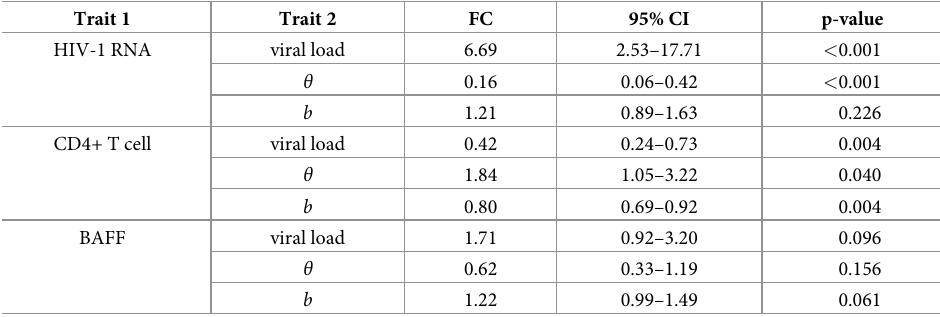
Table 1. Effects of plasma HIV-1 load, CD4+ T cell count and BAFF amount on the Ugandan cohort participants’ median viral load and median values of parameters b and θ . In cohort participants, median viral load detected via qPCR and values of parameters b and θ are influenced by the CD4+ T cell count, HIV-1 plasma viral load, and the amount of BAFF in serum. The fold-change (FC) in participants’ median viral load, or model-fit b and θ values for every log 10 increase in HIV-1 RNA copies/mL, every 100 CD4+ T cell/mm 3 increase, and every 100 pg/ml increase in BAFF is shown. Note that data on CD4+ T cell count and HIV-1 RNA was only available for HIV-1 coinfected